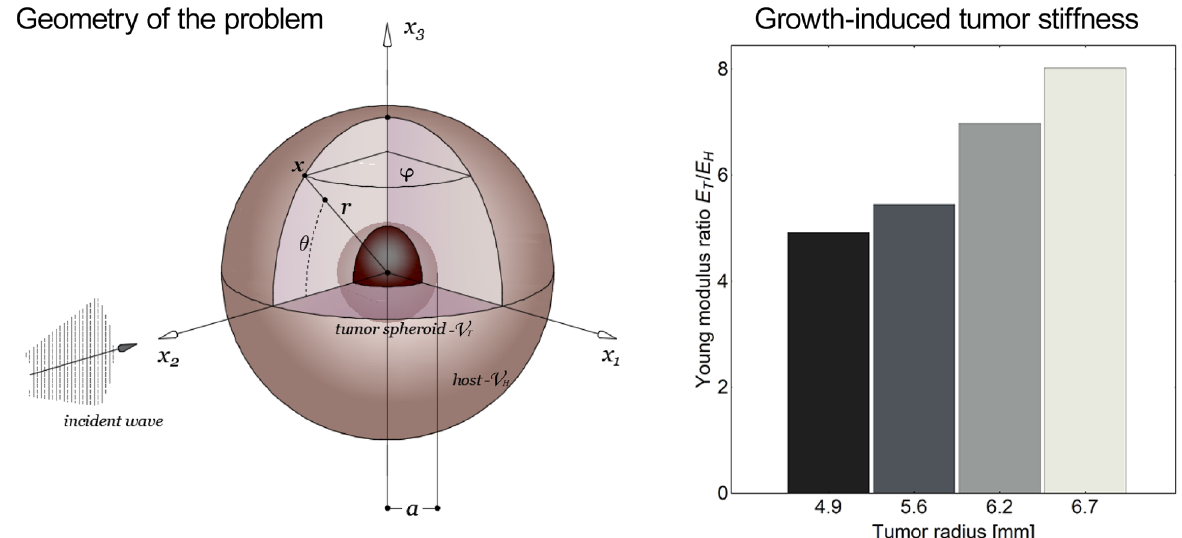
Figure 1. (Left) Geometry of the growing spherical tumor immersed in the healthy surroundings, in which the incident field is propagating and (right) corresponding evolution of the tumor-to-host stiffness ratio as a function of tumor radius, the reported data (adapted from Carotenuto et al. 41 ) being obtained from ex vivo compression tests on breast solid tumors obtained from inoculated MDA-MB-231